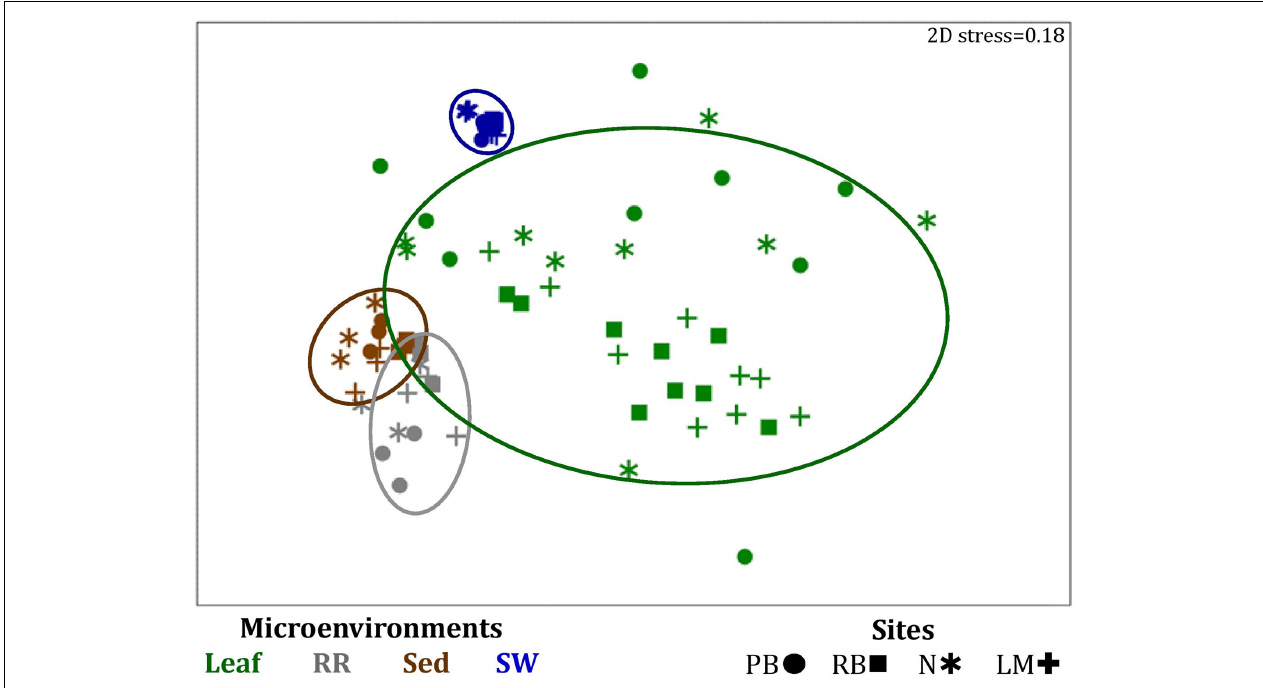
FIGURE 4 | Microenvironmental and regional partitioning of the seagrass bacterial microbiome. Non-parametric multidimensional scaling (nMDS) of bacterial microbiomes ( n = 72), based on a lower triangular resemblance calculated with the S17 Bray-Curtis similarity measure from relative abundances of OTUs (high values down-weighted with square root). Samples are colored by microenvironment (Leaf: upper and lower sections, RR, roots and rhizomes; Sed, sediment; SW, seawater), with different shapes for sites (PB, Palm Beach; RB, Rose Bay; N, Narrabeen Lagoon; LM, Lake Macquarie). Sample clustering patterns by microenvironment are shown in ellipses in the nMDS plot, representing the level of similarity between samples based on the degree to which OTUs are shared between them. The 2D stress is shown in the upper right corner of the nMDS plot (Kruskal stress formula = 1, minimum stress = 0.01). The nMDS for the three microenvironments within the phyllosphere is provided in Supplementary Figure 3 and a hierarchical cluster analysis (CLUSTER) for all samples is provided in Supplementary Figure 2